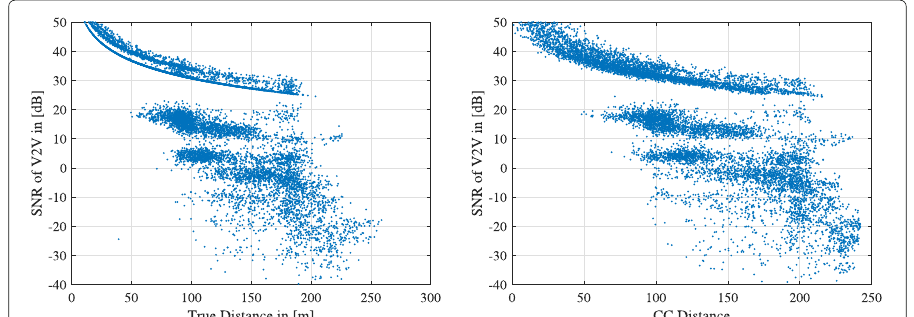
Fig. 9 Scatter plot of the average SNR of V2V links as a function of true distance (left plot) and CC distance (right